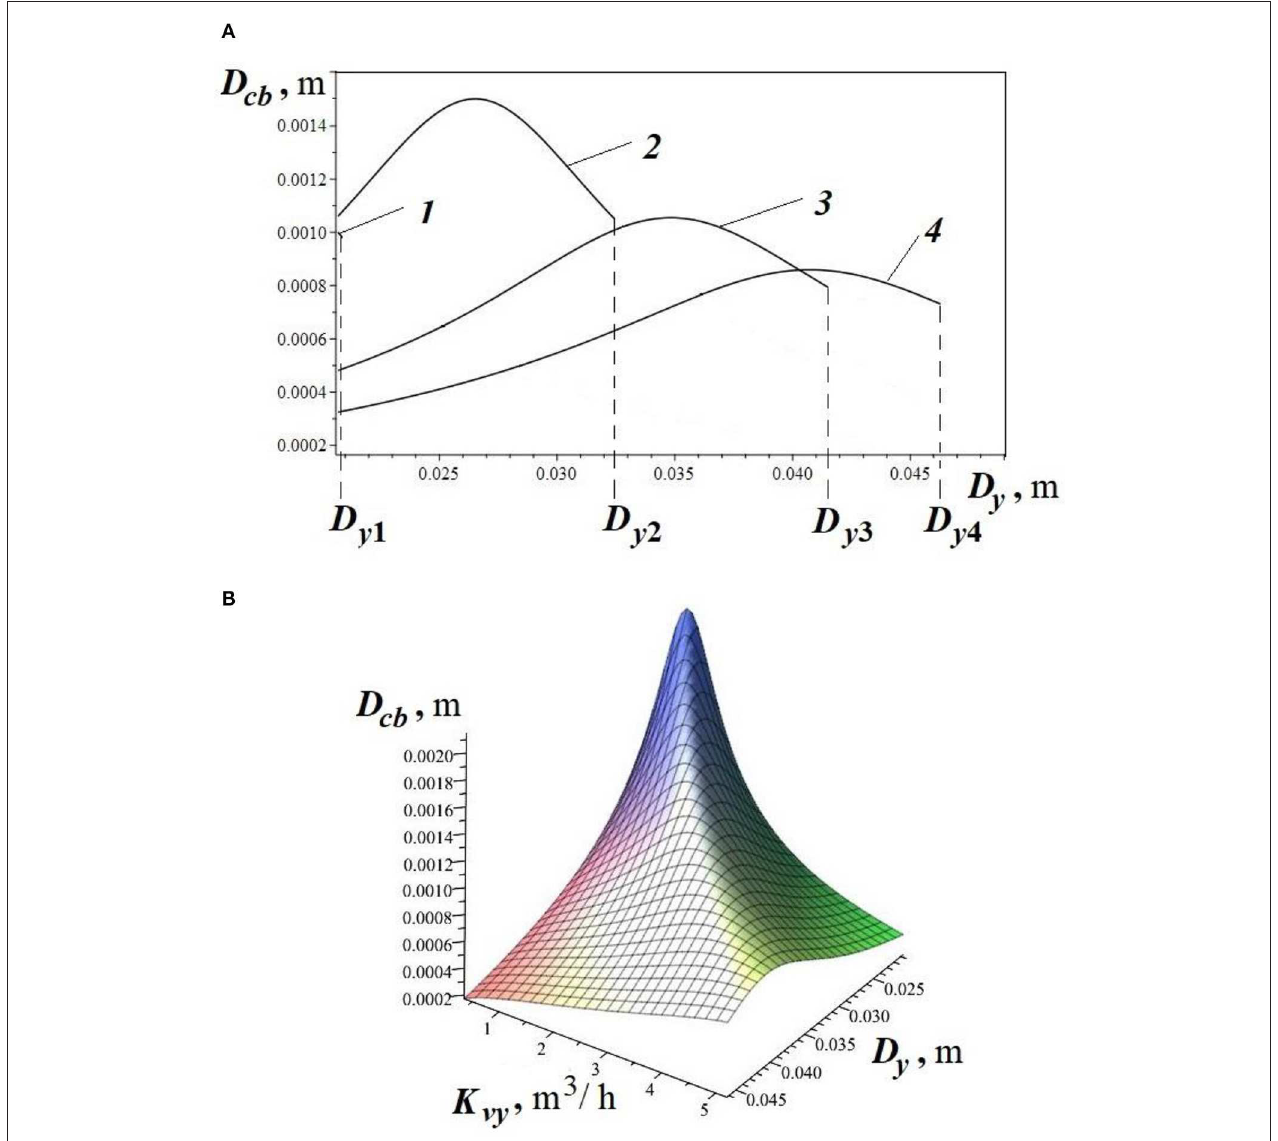
FIGURE 4 | The influence of the main indicators of the process of throttling the working medium in the node “separator-external locking shell” on the value of the ensemble average diameter of the cavitation bubble by the example of the dependencies: (A) D cb ( D y ); 1 – z 2 –